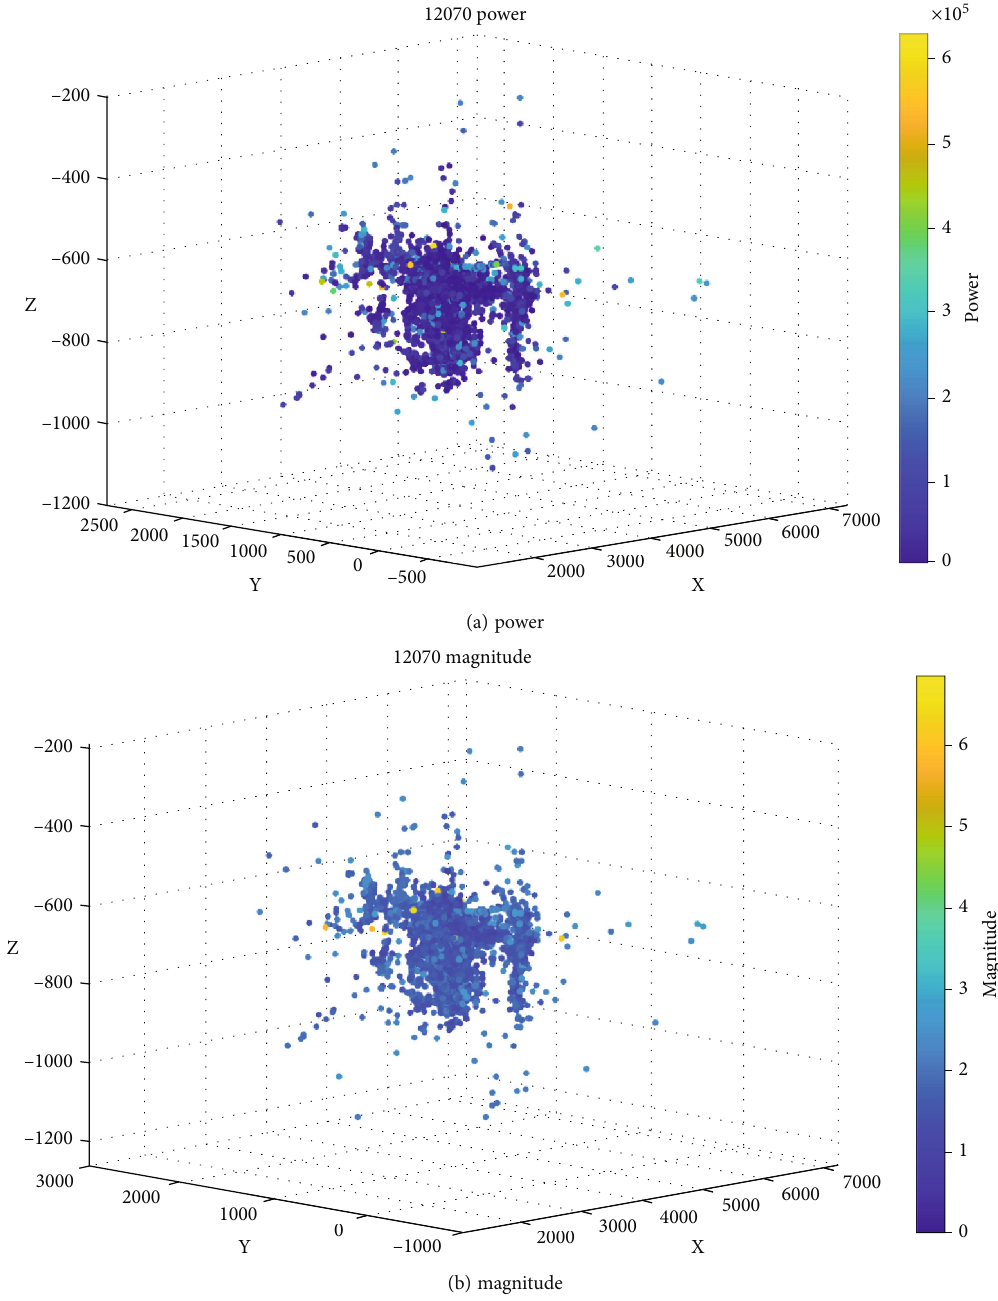
Figure 2: Energy and magnitude of 12070 working face coal